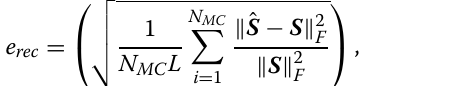
Table 4 Performance of the proposed method versus L